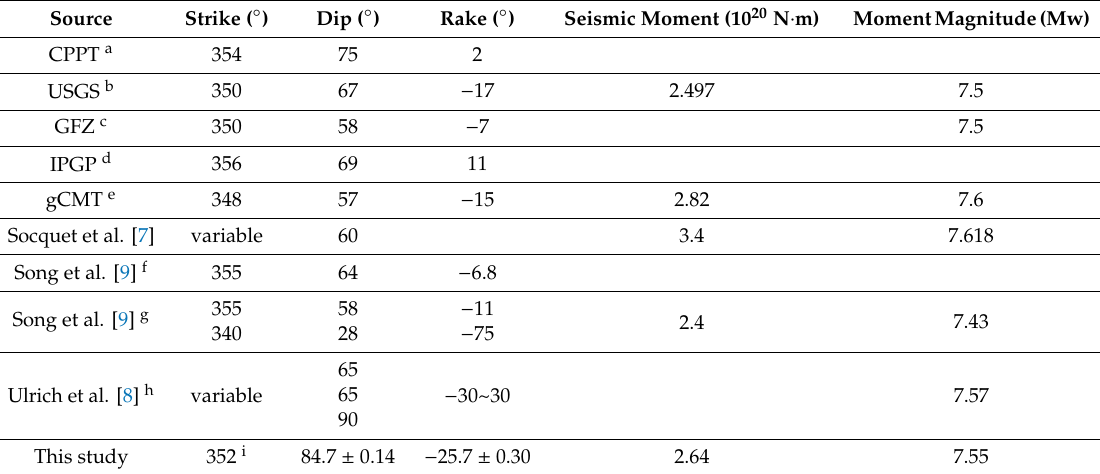
Table 1. Source parameters estimated from di ff erent